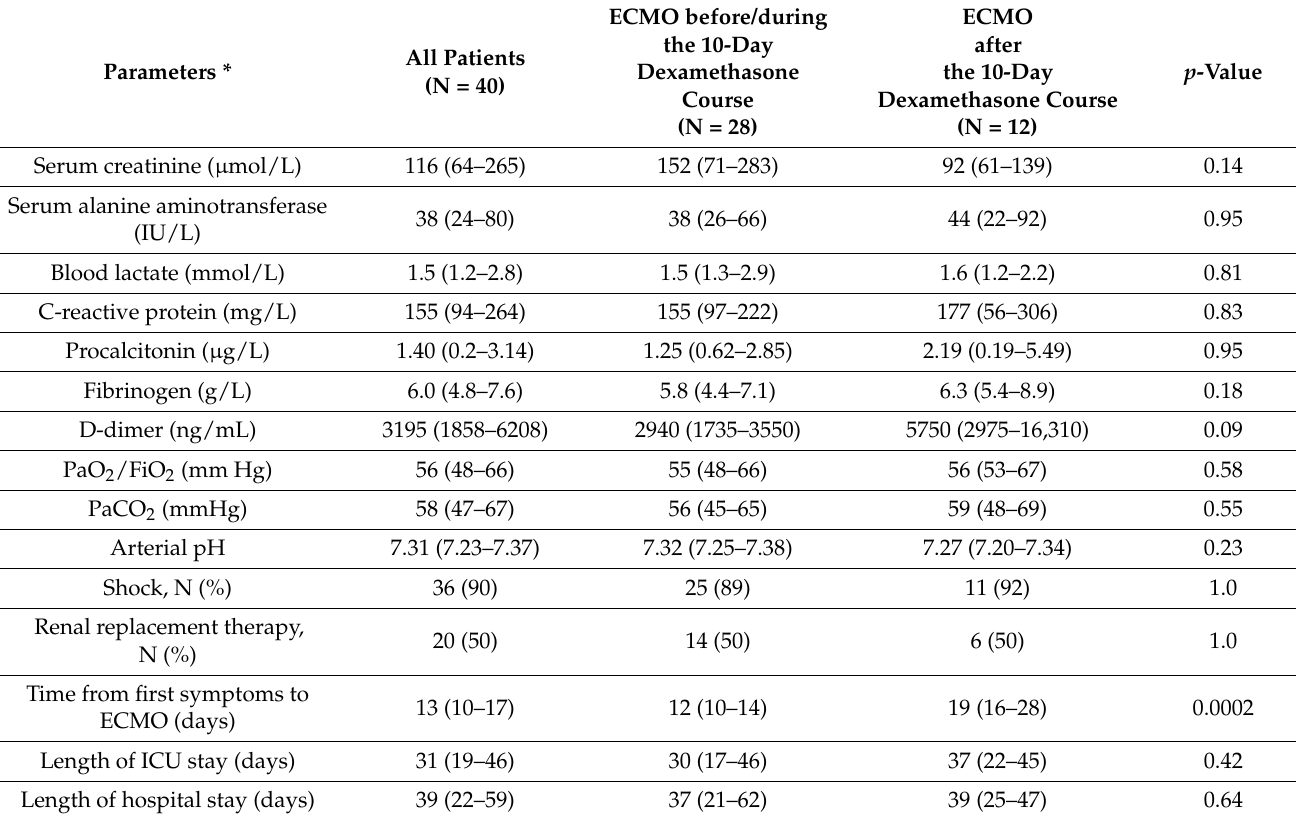
Table 2. Parameters at ECMO implementation.